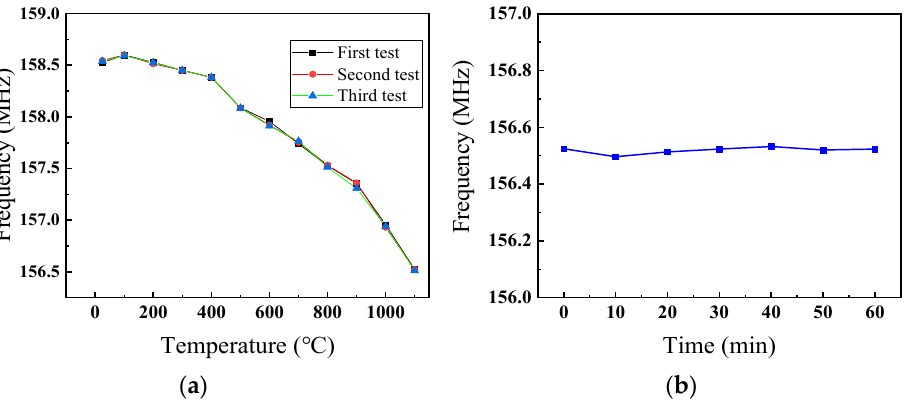
Figure 5. ( a ) The three repeatability experiments of extraction points and curves were between frequency and temperature; ( b ) frequency change graph of heat preservation sensor at 1100 °C.